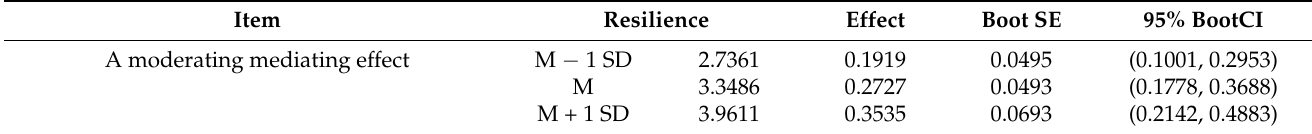
Table 5. Mediating effects at different levels of resilience.